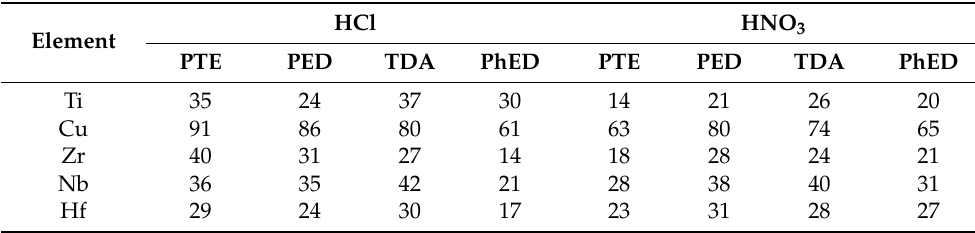
Table 5. The effect of acids, recovery, %. Sorption conditions: 0.1 mol/L HCl/HNO 3 , m sorbent = 0.1